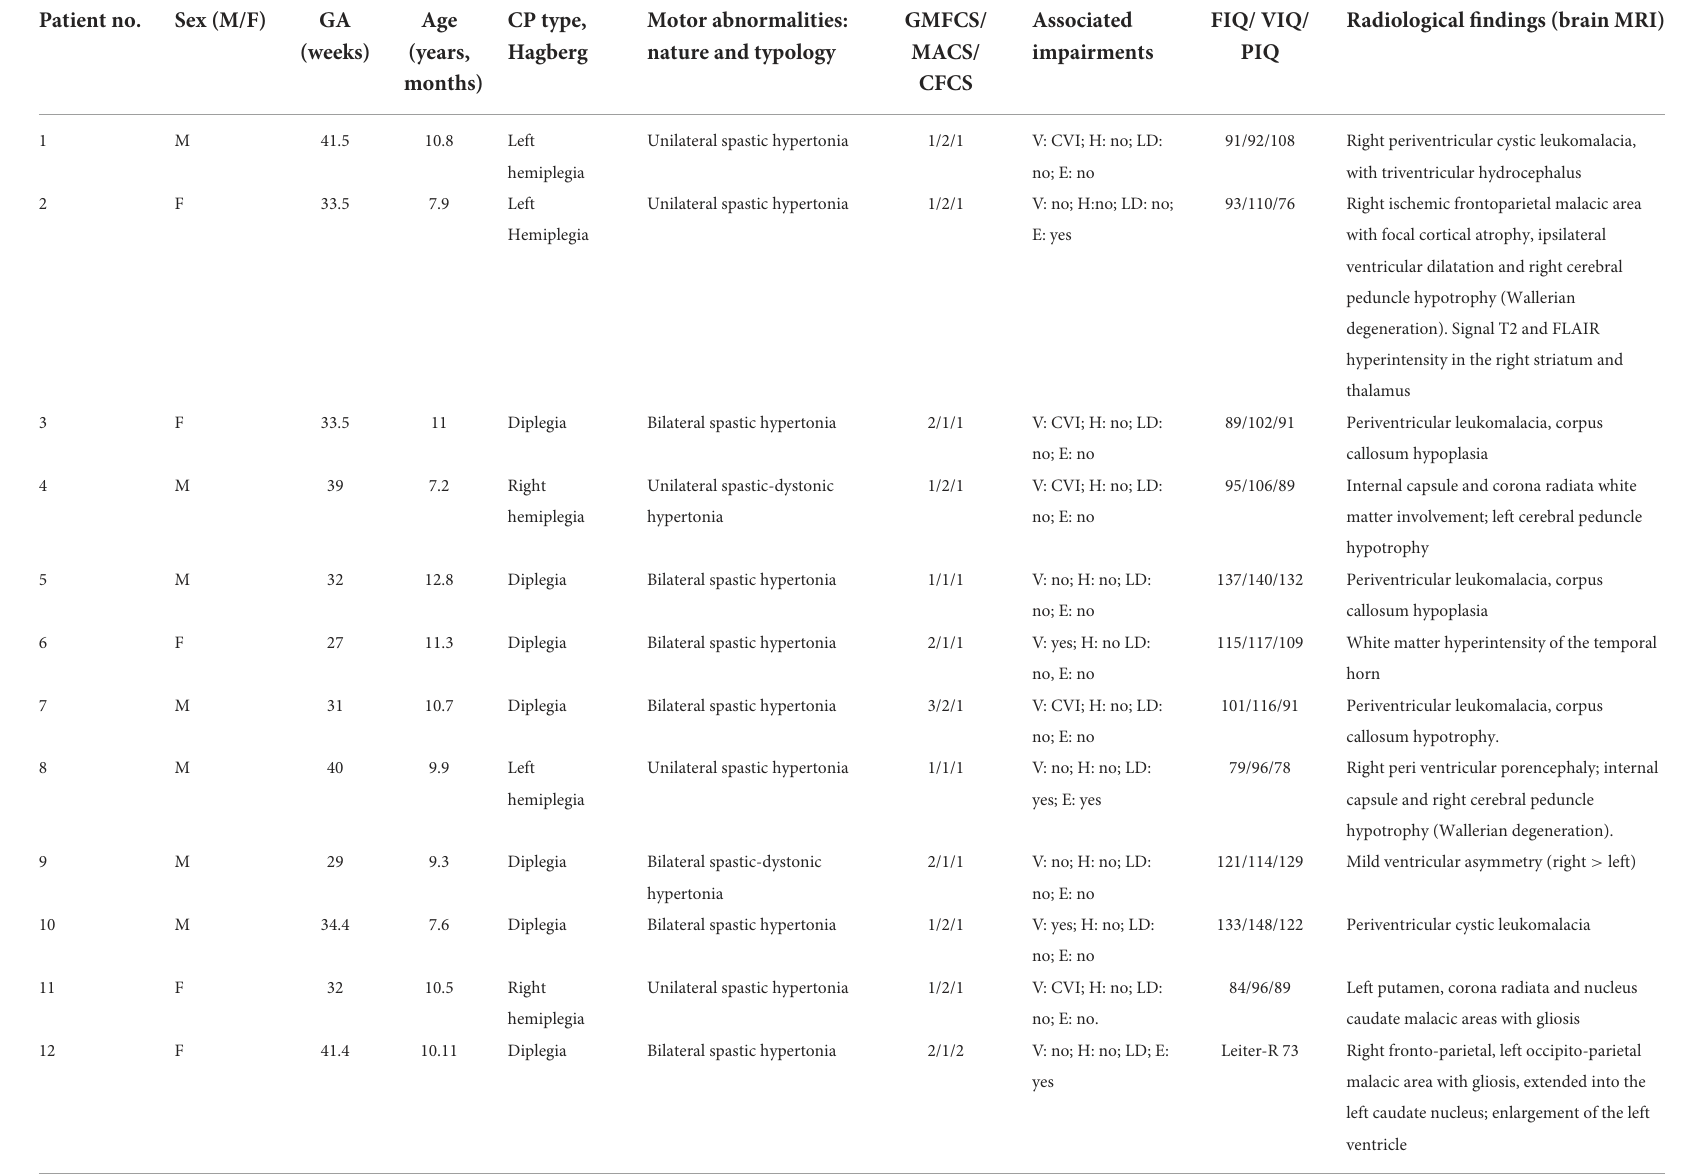
TABLE 1 Demographic data, clinical features, and radiological findings in participants. Patient